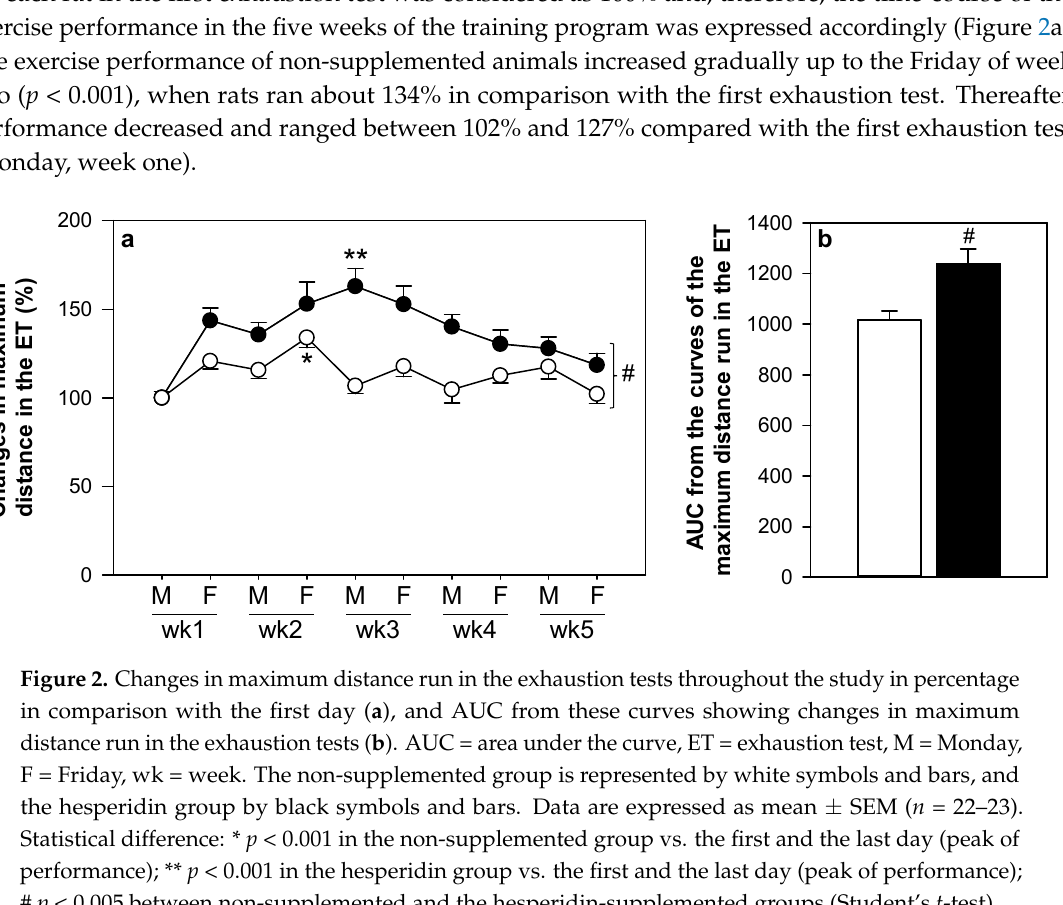
Table 1. Body weight of the animals at the beginning of the study, and before and after the five-week training program and hesperidin supplementation (day 20 and 52, respectively), and food intake before and after the five-week training program and hesperidin supplementation.